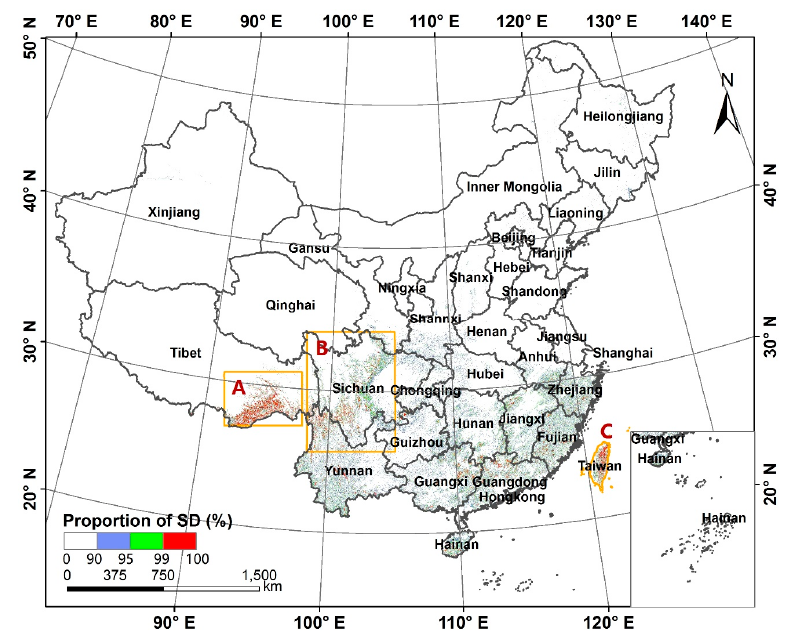
Figure 14. Percentile distribution of standard deviation of four LAI climatologies over China. Blue represents 90% percentile level, green represents 95% percentile level, and red represents 99% percentile level.